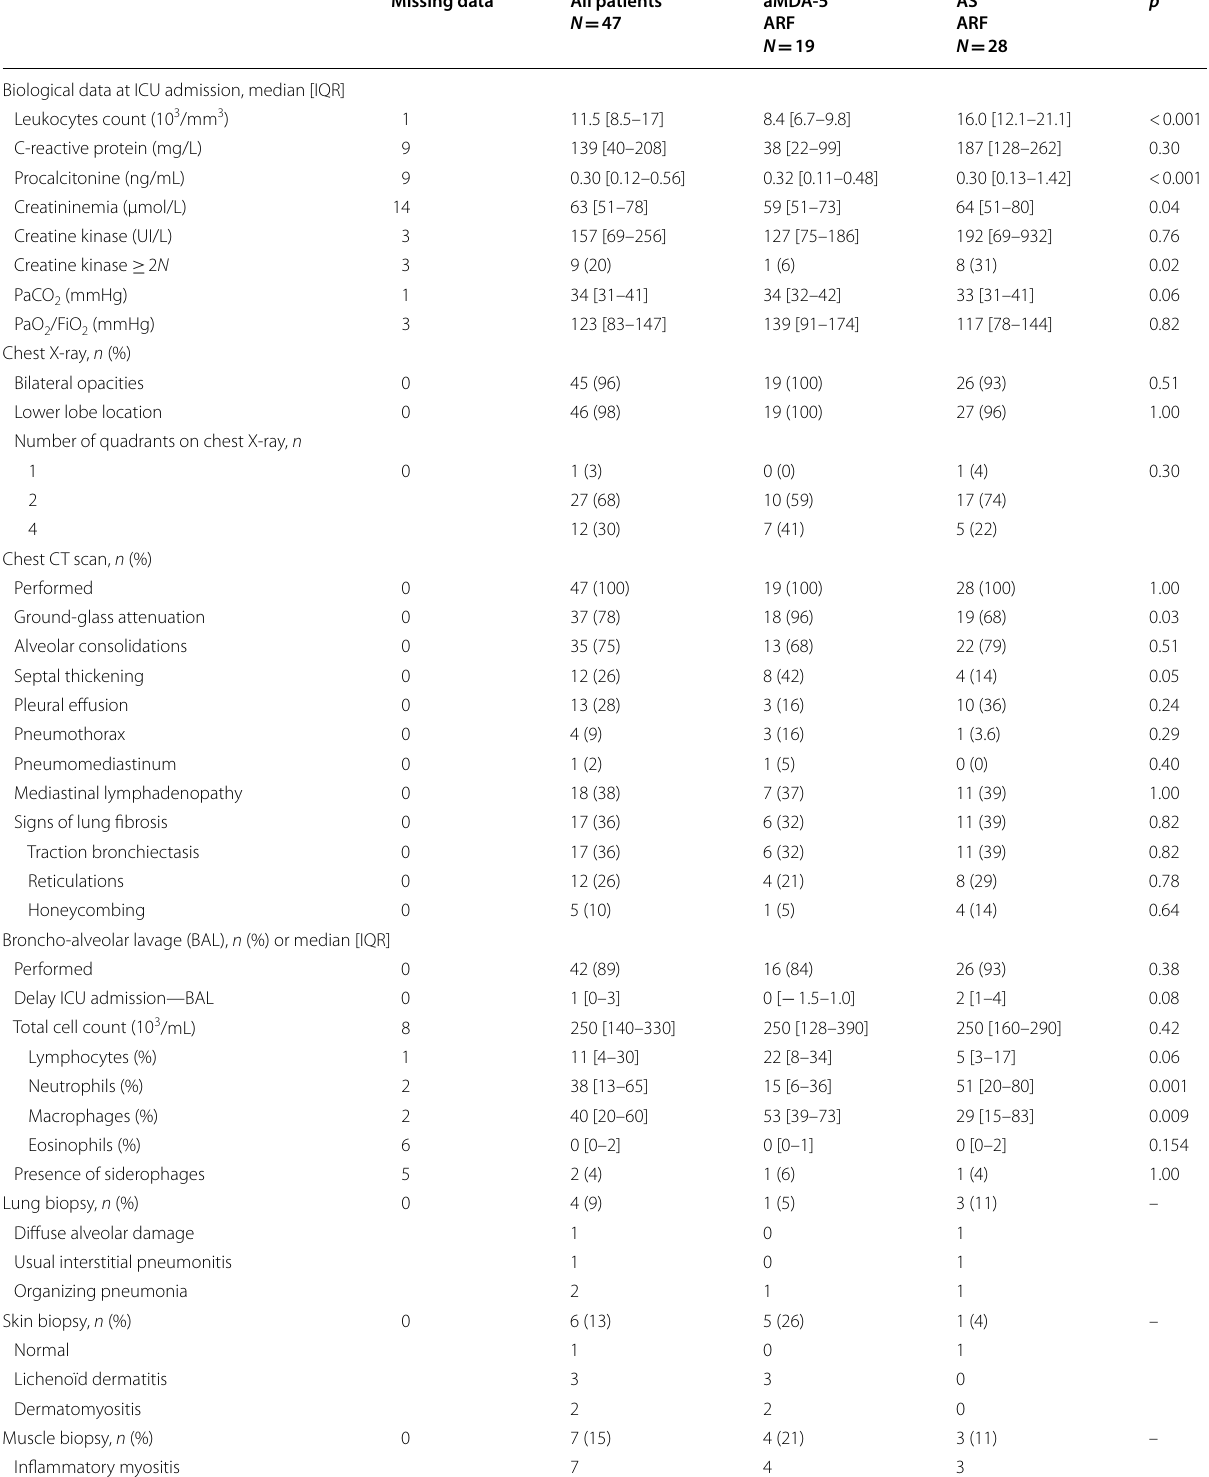
Table 2 Biological, radiological and cytological findings in patients with acute respiratory failure revealing anti- synthetase syndrome or dermato-pulmonary syndrome associated with anti-MDA-5